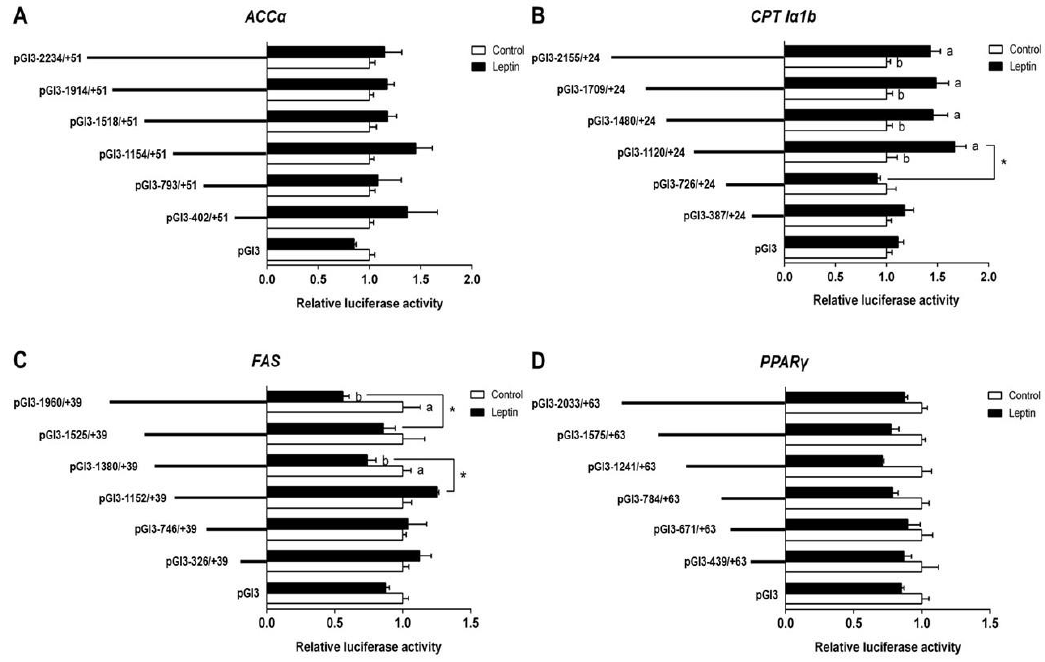
Figure 2. 5′ unidirectional deletion assays for promoter regions of ACC α , CPT Iα1b , FAS and PPARγ after leptin treatment. ( A ) Assays for the ACC α promoter region; ( B ) assays for the CPT Iα1b promoter region; ( C ) assays for the FAS promoter region; ( D ) assays for the PPARγ promoter region. Values showed the ratio of activities of firefly to Renilla luciferase , normalized to the control. Results were presented as mean ± SEM ( n = 3). Asterisk (*) indicates significant differences between different 5′ unidirectional deletion plasmids under the same treatment ( p < 0.05). Different letters indicate significant differences between different treatments in the same plasmid ( p < 0.05).